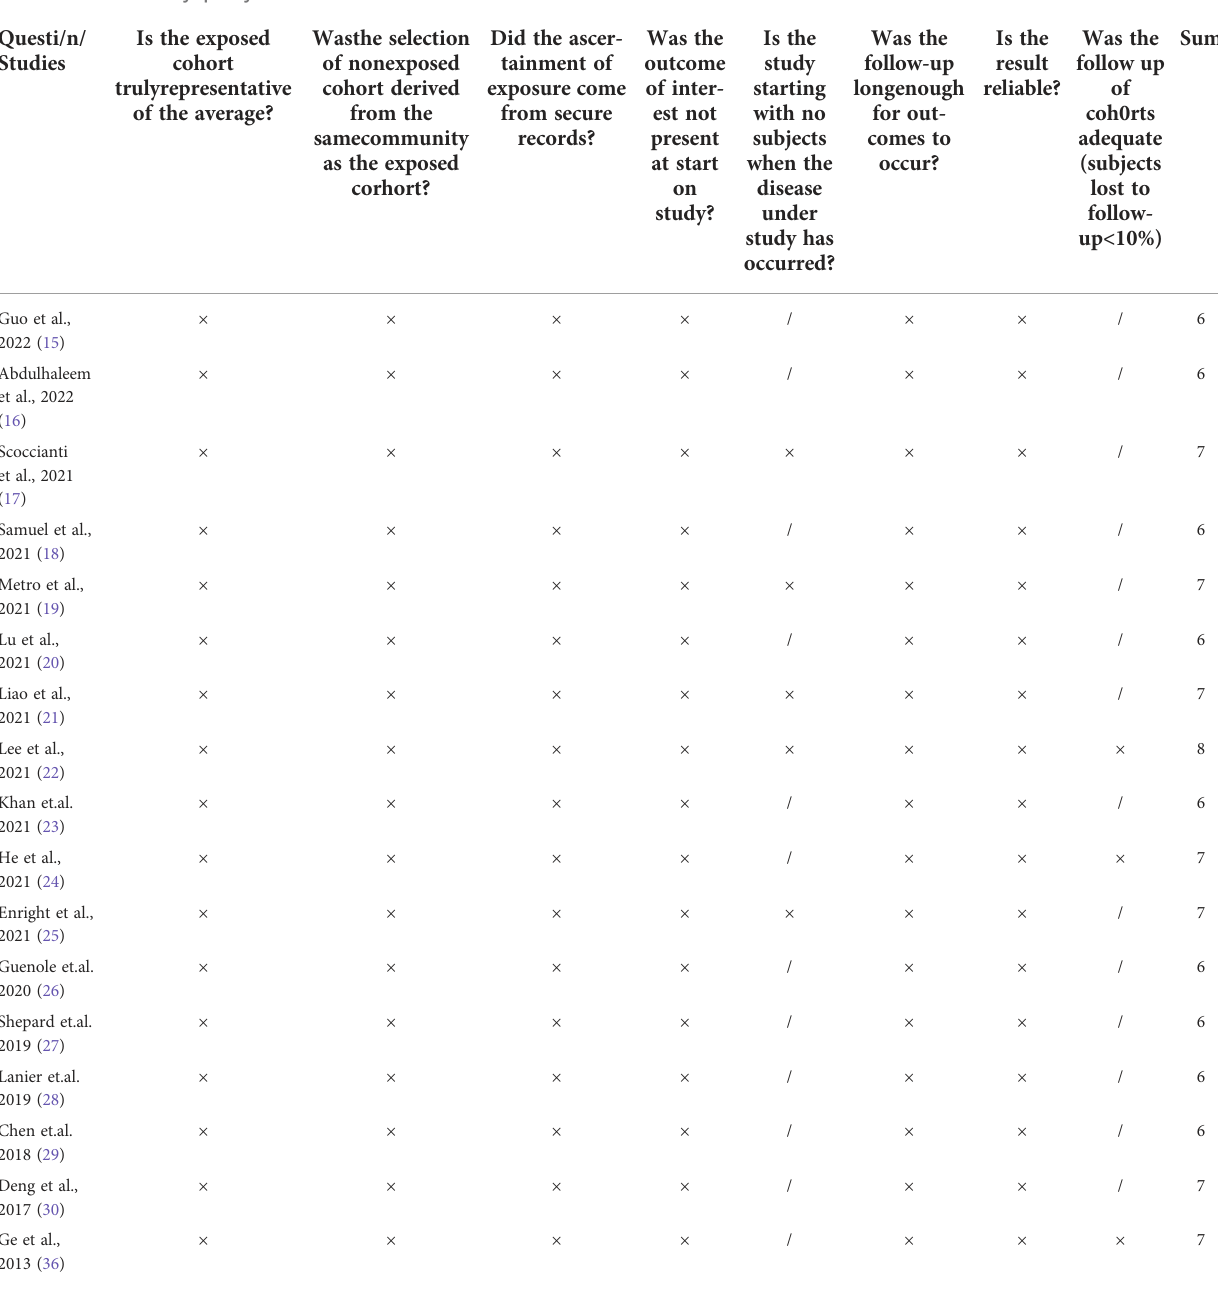
TABLE 2 Cohort study quality